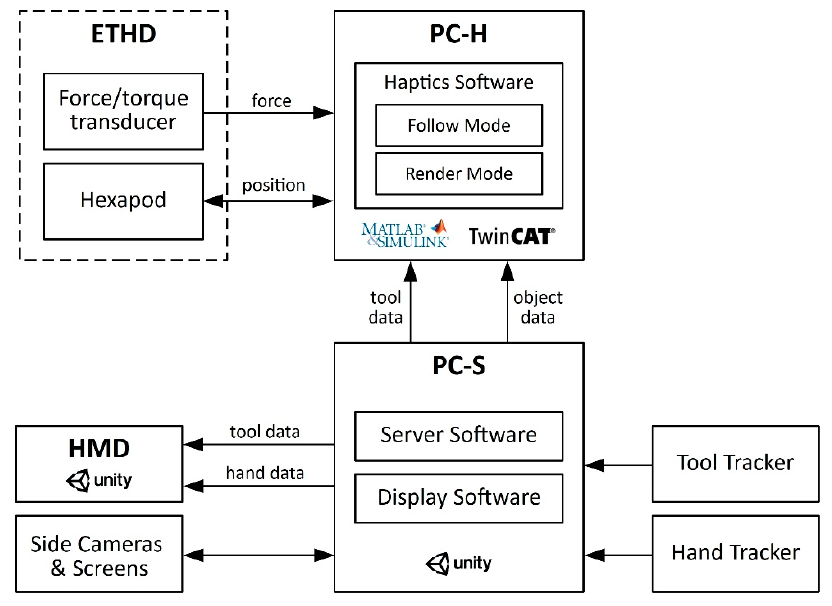
Figure 5. System Figure 5. System architecture. Figure 5. System architecture.